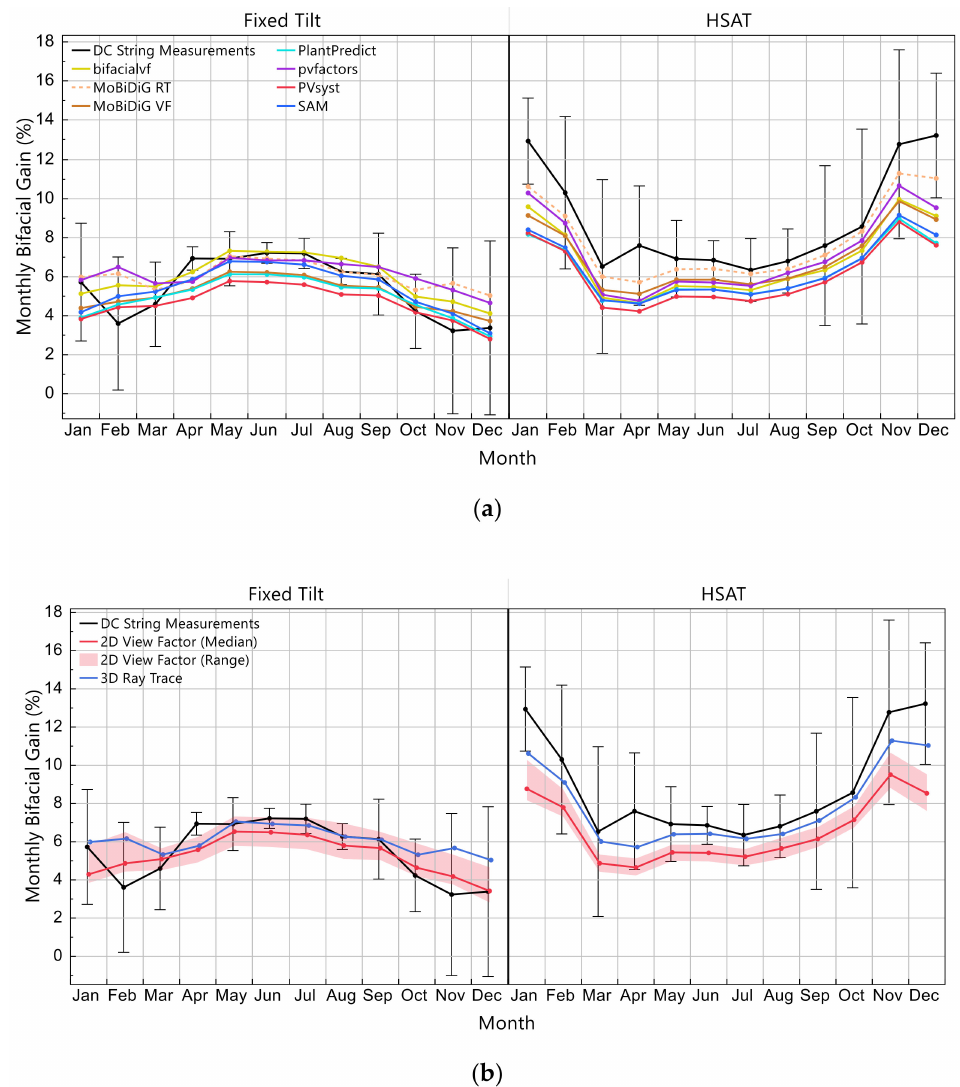
Figure 12. Monthly bifacial gain on fixed-tilt and HSAT systems calculated with Equation (2). All plots show bifacial gain as simulated by seven software and from DC string measurements. The black error bars show the inner quartile range of daily bifacial gain measurements within each month. Datapoints when sun elevation is lower than 5 ◦ above the horizon are not included in these plots. ( a ) Results grouped by software (Table 1). ( b ) Results grouped by whether a 2-D view factor or 3-D ray trace approach was used to calculate back side